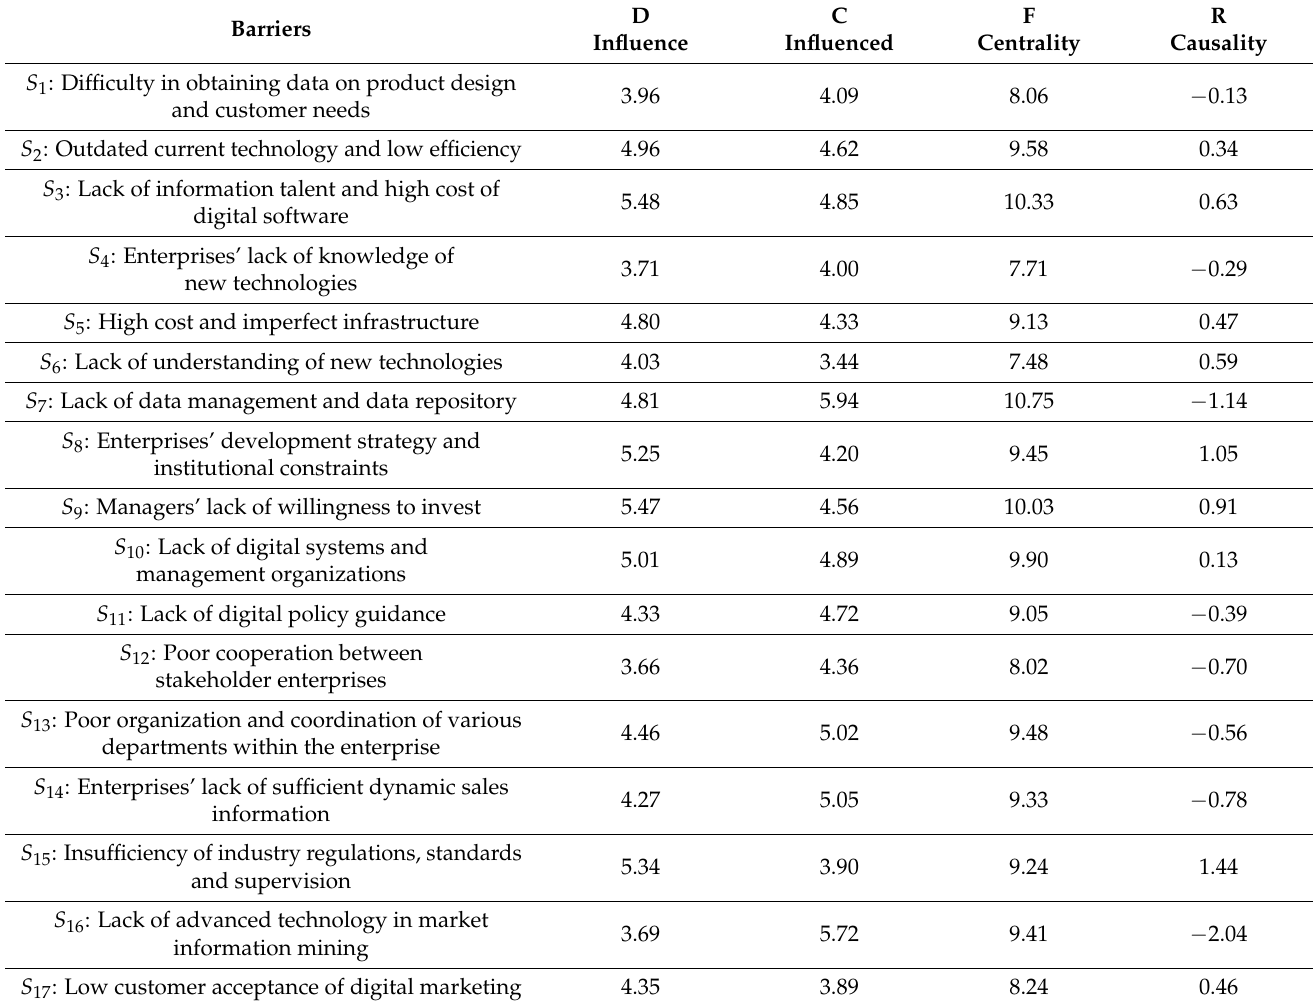
Table 9. DEMATEL model comprehensive analysis